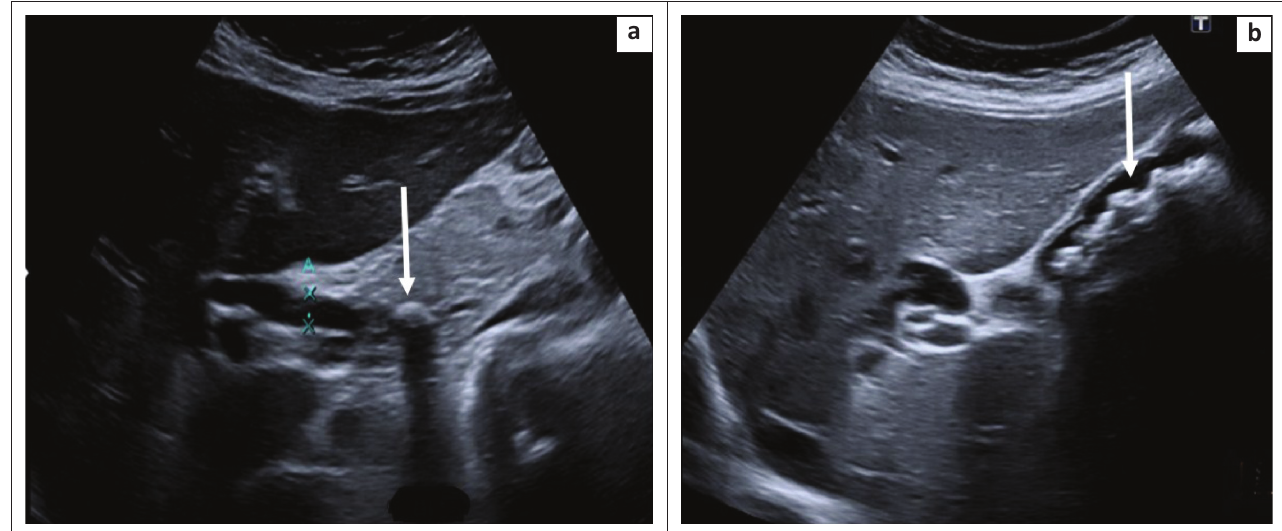
FIGURE 4: Example of a benign cause for biliary obstruction: (a) Obstructing calculus (white arrow) in the distal common bile duct as a rounded echogenic structure with posterior acoustic shadowing, causing proximal dilatation of the common bile duct; (b) multiple gallbladder calculi (white arrow) in the same